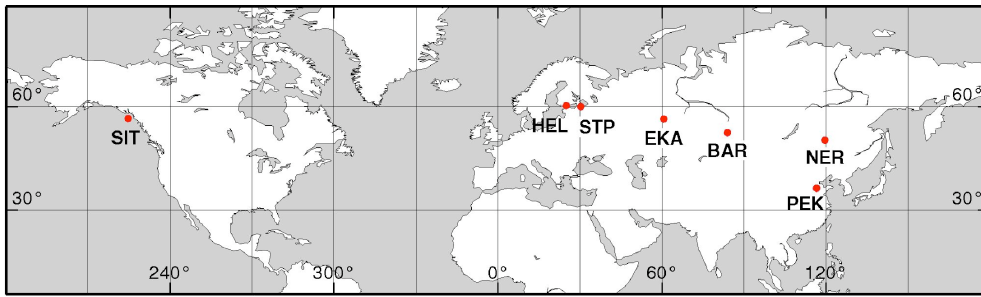
Fig. 1. Geomagnetic observatories used in this study: HEL (Helsinki, Finland) and the Russian observatories STP (St. Petersburg), EKA (Ekaterinburg) (Catherinburg), BAR (Barnaul), NER (Nertchinsk), PEK (Peking, now Beijing) and SIT (Sitka) (see Tables 1 and 2).